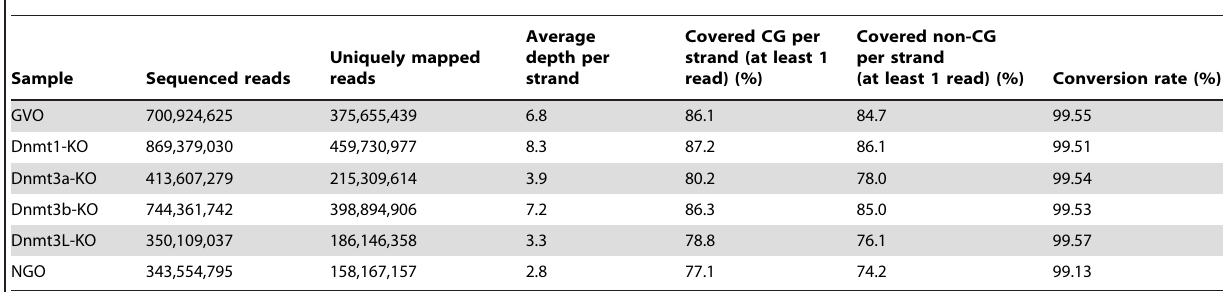
Table 1. Sequencing and mapping